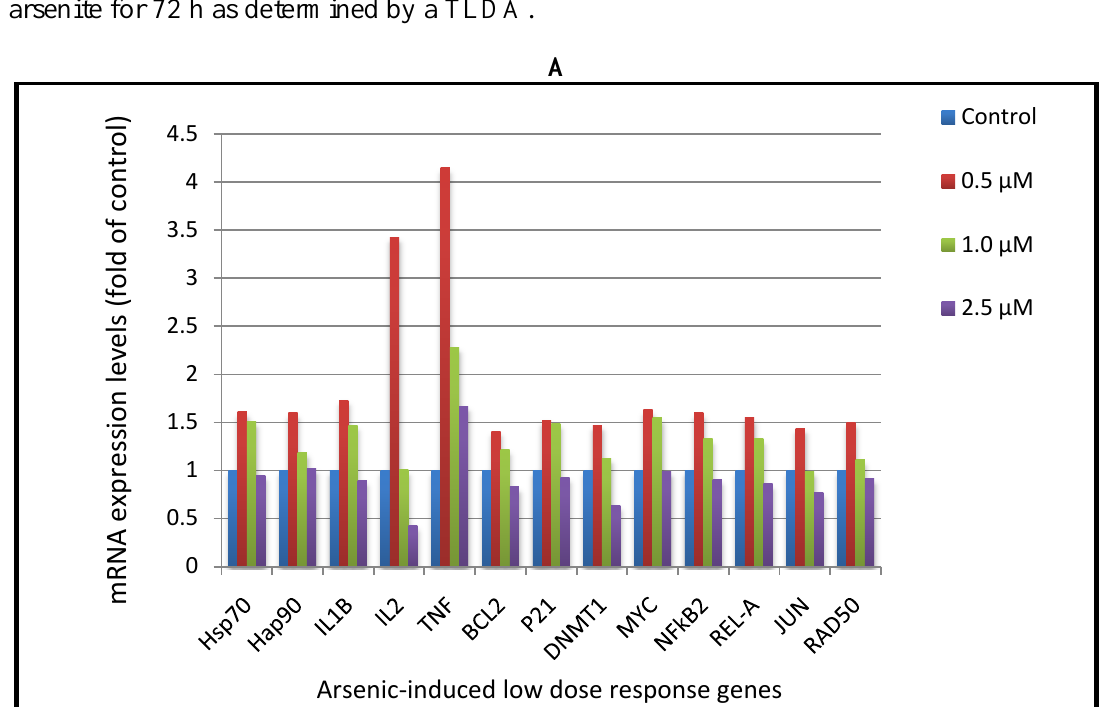
Figure 3. Gene expression analysis of cardiomyocyte AC16 cells exposed to sodium arsenite for 72 h as determined by a